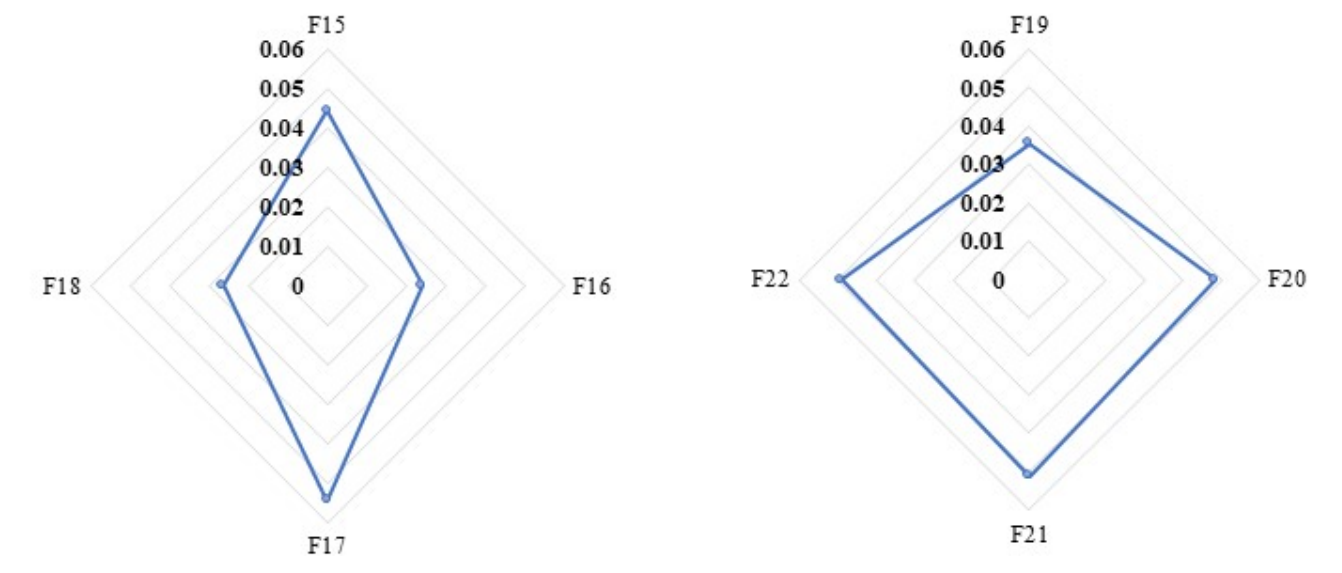
Figure 3. The final weights of each indicator.